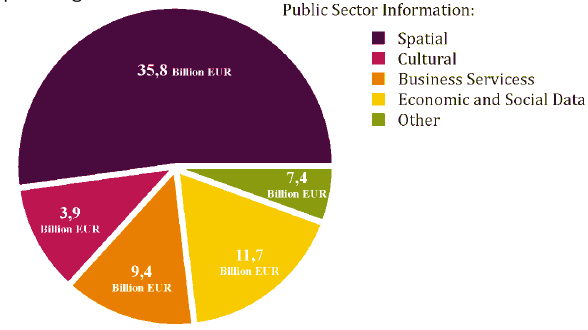
Figure 1: Economic value of public sector information in the European Union in 1999 (Pira International Ltd. & University of East Anglia and KnowledgeView Ltd.